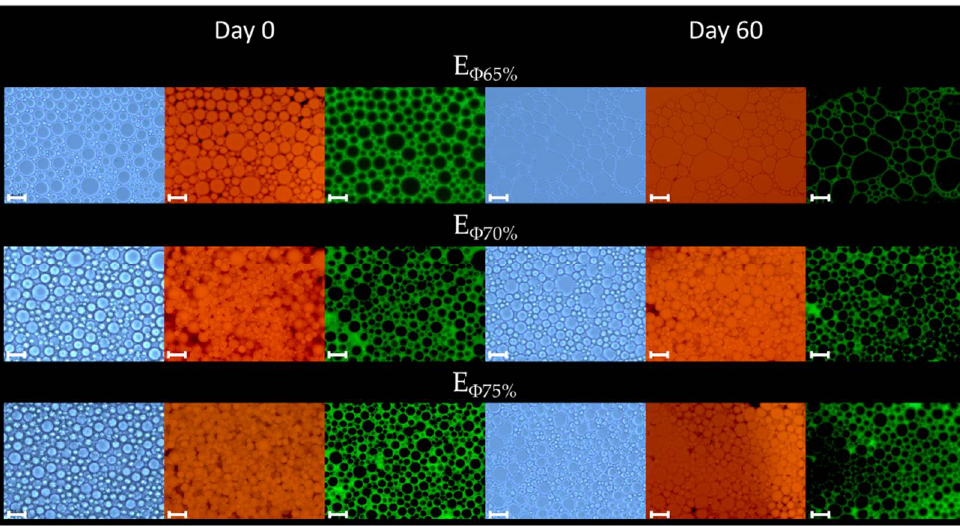
Figure 2. Optical and fluorescence microscopic images of E Φ65% , E Φ70% , and E Φ75% at days 0 and 60; of storage at 25 °C (bar scale: 20 µm). Protein was dyed with FITC (green) and CO with Nile